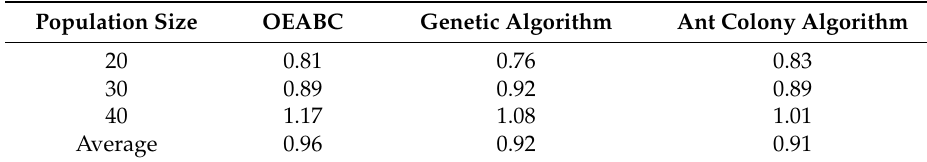
Table 8. The convergence